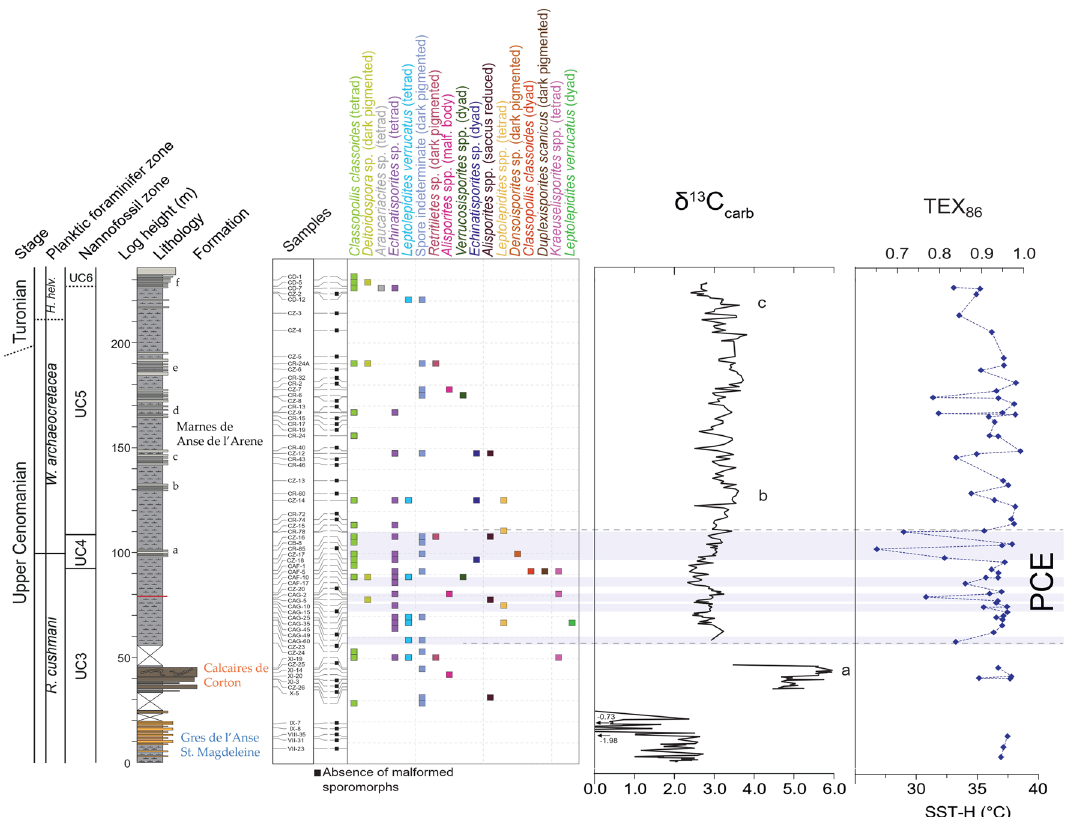
Figure 2. Stratigraphical distribution of malformed sporomorphs in the Cassis section. Presence/absence data of abnormal morphological variation in sporomorphs. Each cross represents a minimum of two occurrences of the respective sporomorph. Lithological log, biostratigraphy, δ temperatures (SSTs) adapted from 38 . PCE = Plenus Cold Event. Blue horizontal bands represent individual SST cooling episodes during the